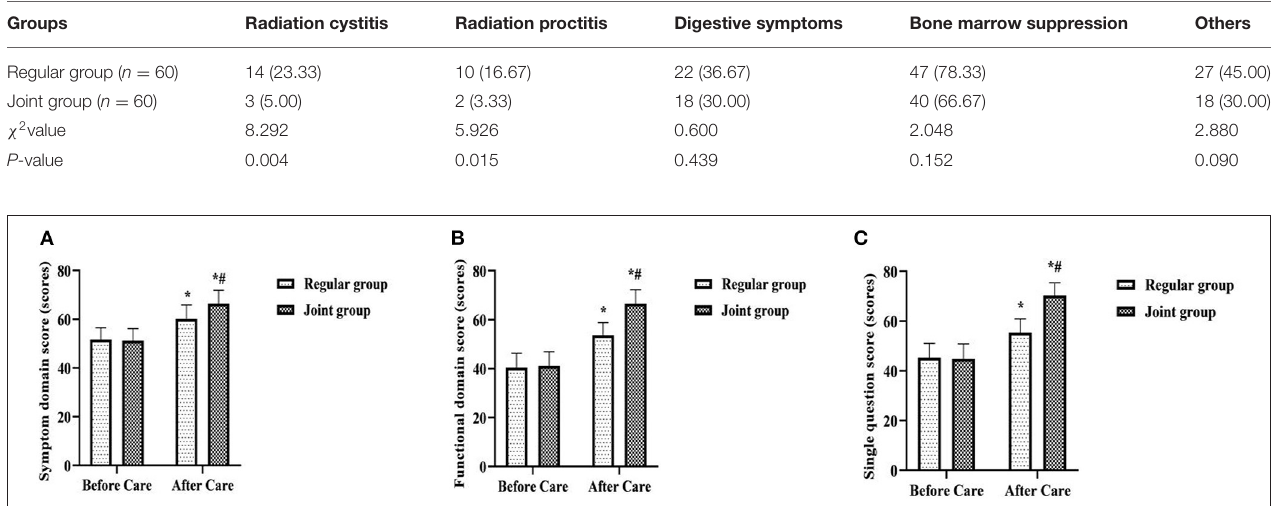
TABLE 2 | Comparison of the incidence of adverse reactions of the two groups ( n , %).